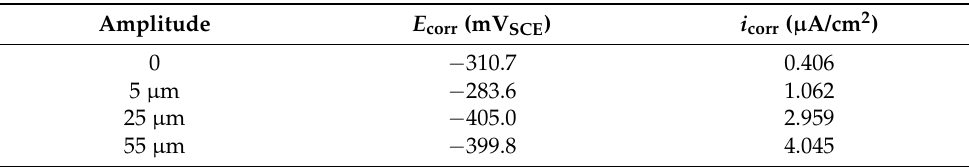
Table 2. Fitting values of electrochemical parameters obtained from potentiodynamic polarization plots at different CE